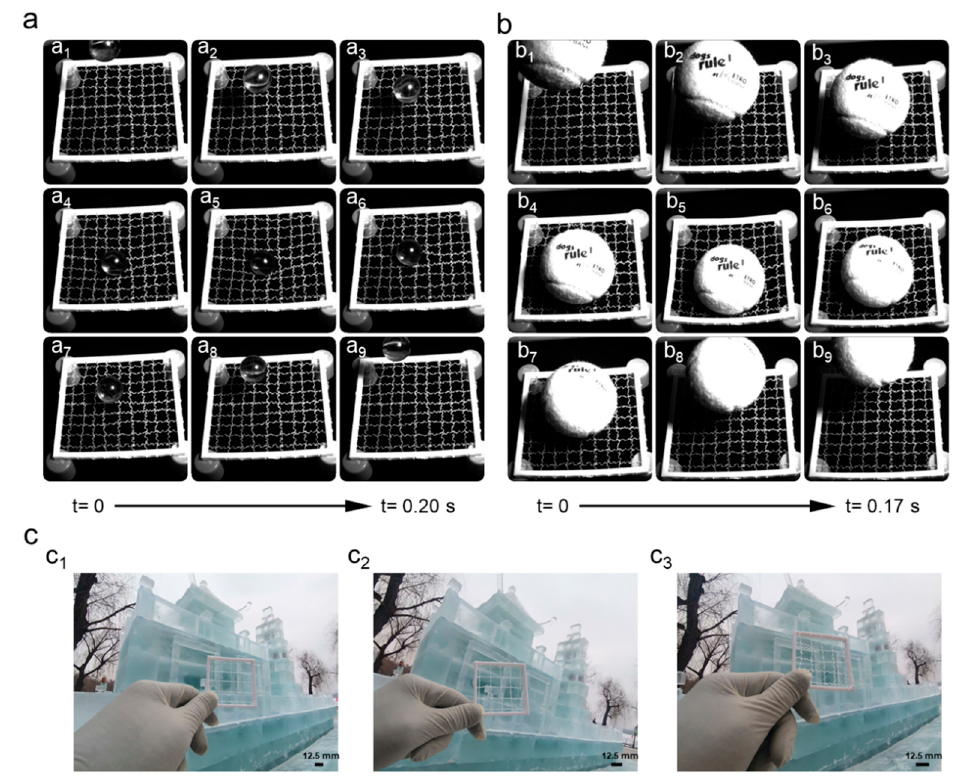
Figure 9. The glass ball impacts the bio-inspired spider silk web ( a ); tennis ball impacts the bio- inspired spider silk web ( b ); the concealment of the web woven by bio-inspired spider silk with different levels of stimulation ( c